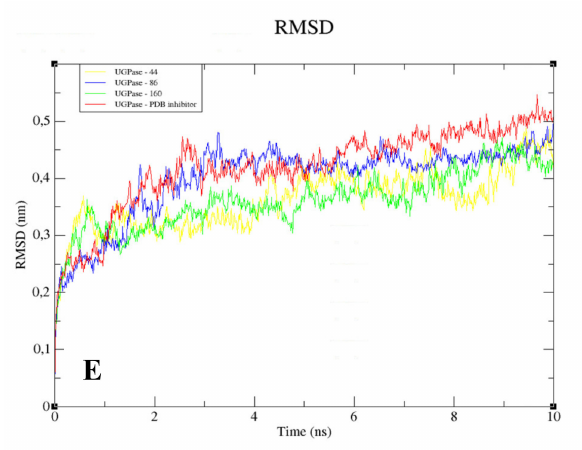
Figure 9. RMSD values for the C α atoms of enzymes complexed to lignans and the Protein Data Bank (PDB) ligand. ( A ) GPDH. ( B ) DHODH. ( C ) PTR1. ( D ) TR. ( E ) UGPase.